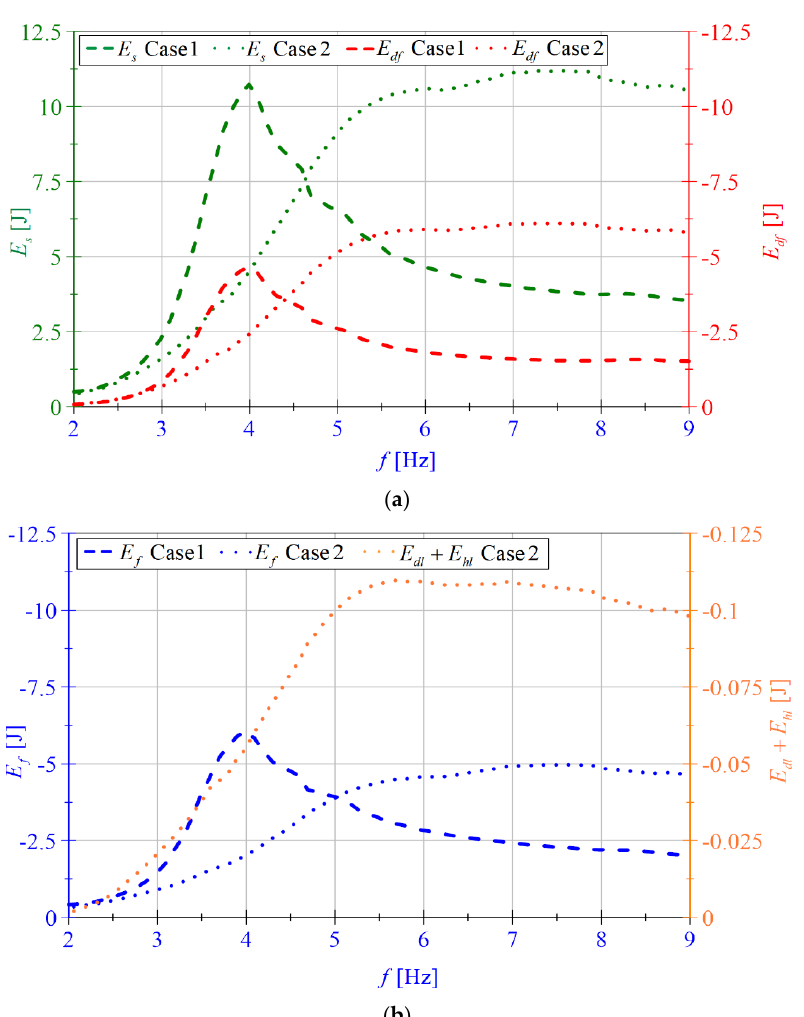
Figure 12. Energy vs. frequency f , ( a ) E s Case 1, E s Case 2, E df Case 1, E df Case 2; ( b ) E f Case 1, E f Case 2, E dl + E hl Case